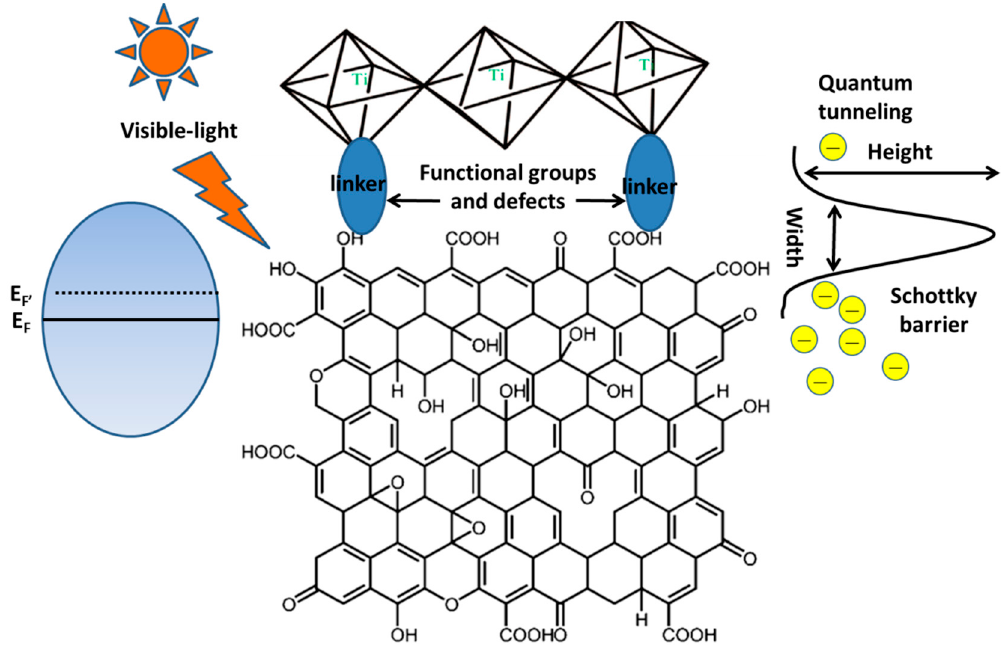
Figure 15. Electron transport between graphene and TiO 2 at their interface.